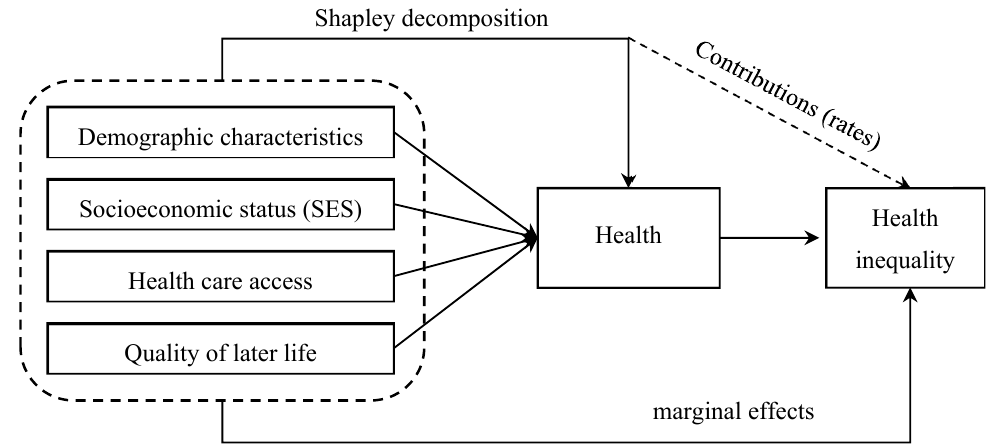
Figure 1. Core research framework.